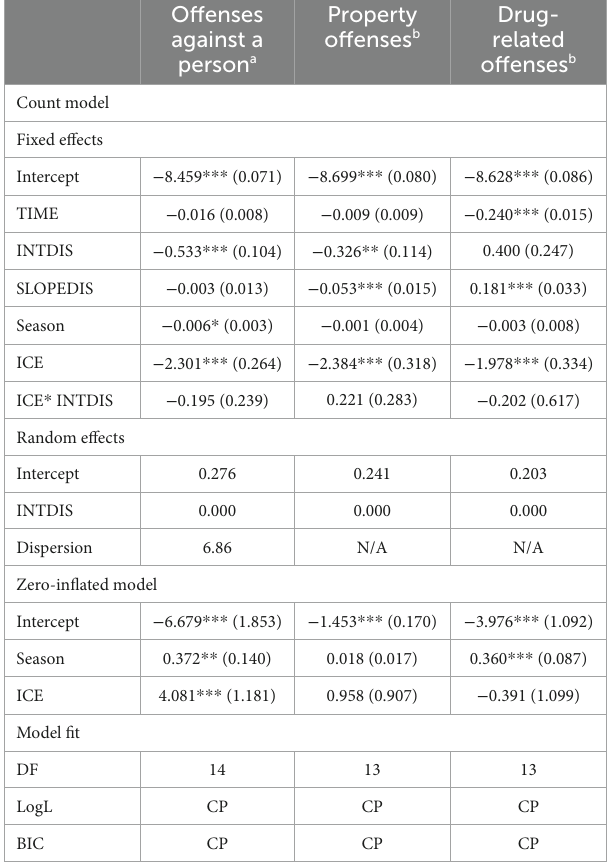
TABLE 5 Conditional discontinuous growth models for accounting for variations in the discontinuity by concentrated affluence and